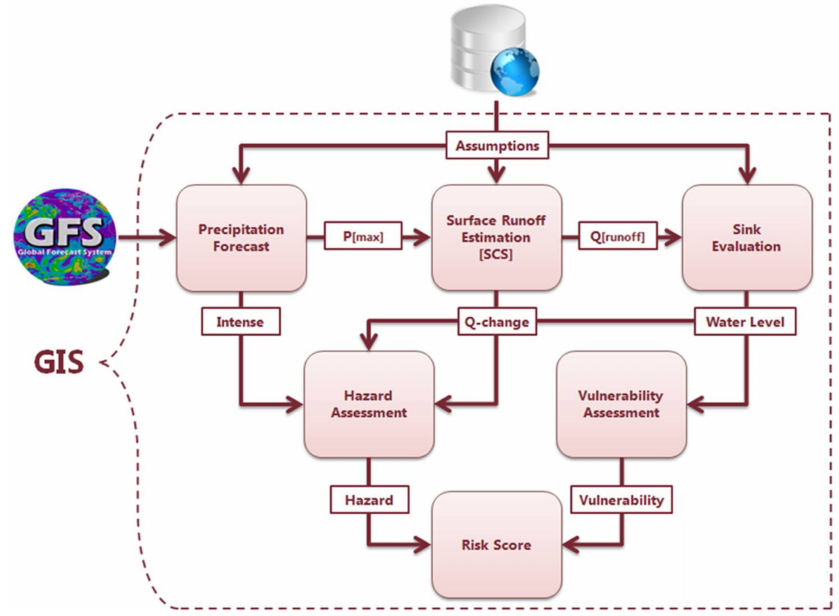
Figure 1. Research framework of Pluvial Flood Risk Assessment